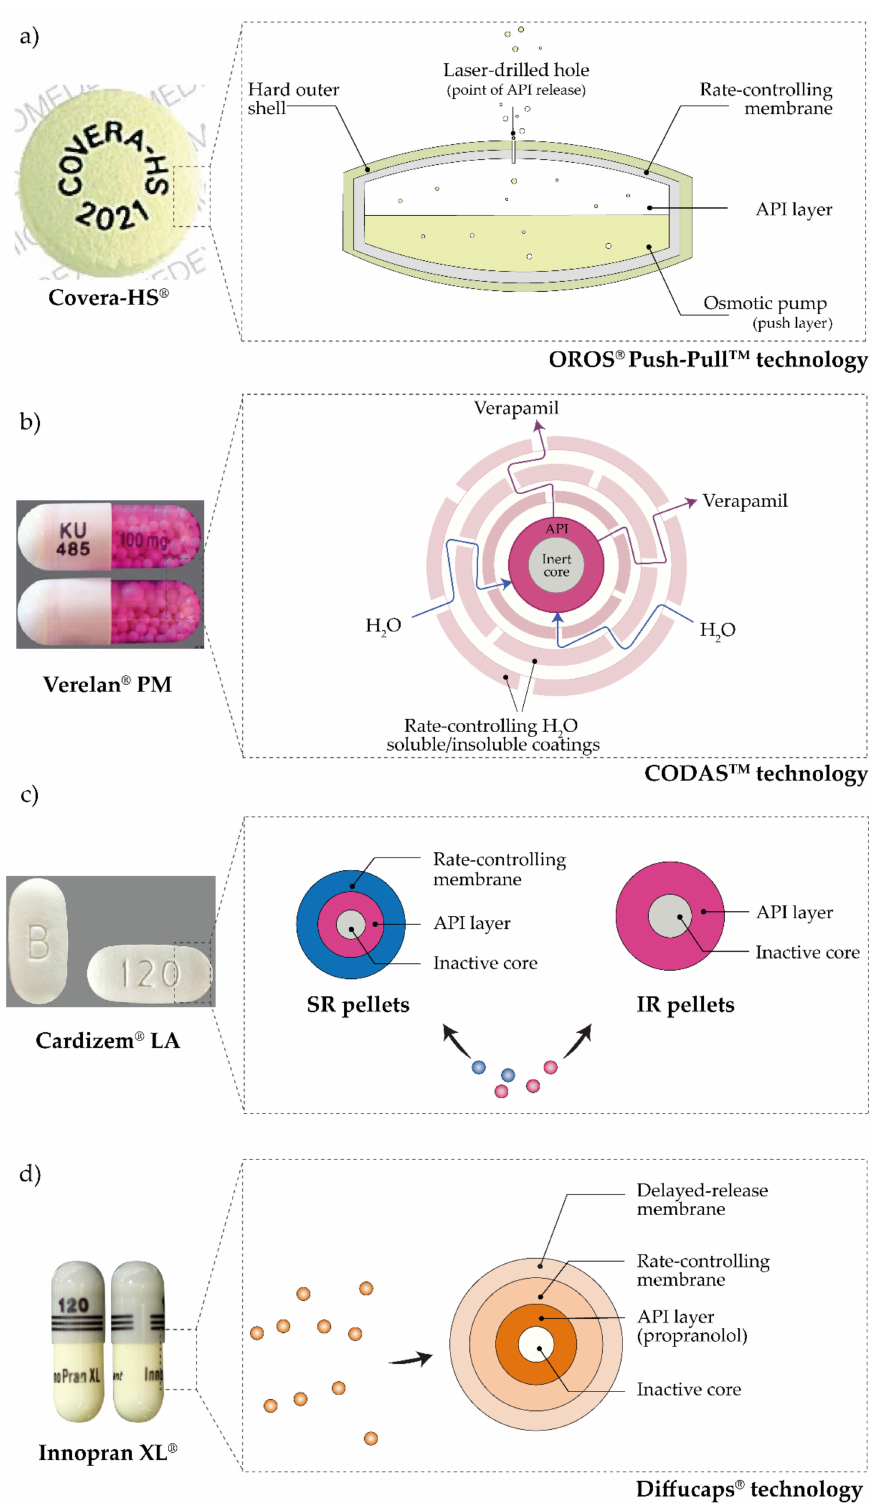
Figure 6. A schematic representation of approved pulsatile antihypertensives drug systems: ( a ) COVERA-HS ® , ( b ) Verelan ® PM, ( c ) Cardizem ® LA, and ( d ) Innopran XL ® (API—active pharma- ceutical ingredient, SR—sustained-release, IR—immediate-release). The image was created with the Adobe Illustrator CC (Version 23.0.1.; Adobe Inc., 2019)